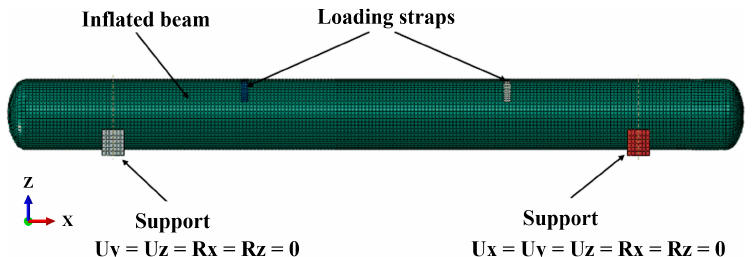
Figure 6. Numerical modeling.